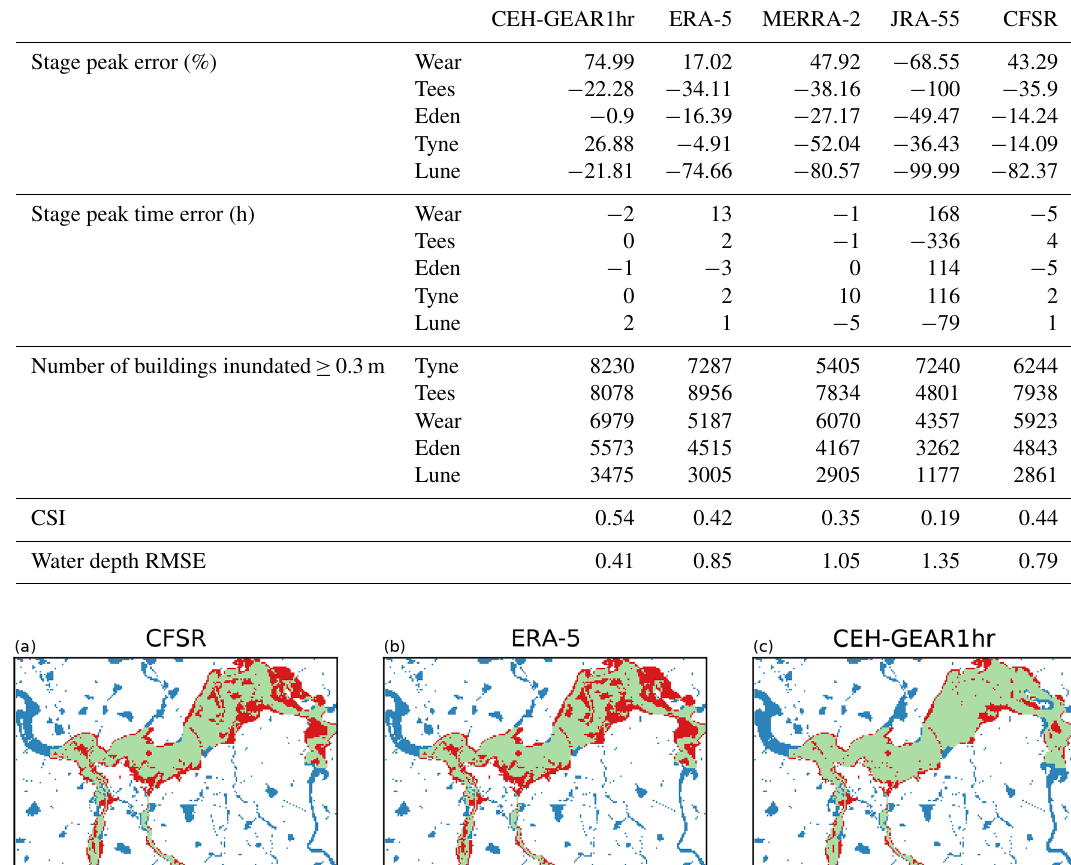
Table 3. Summary of metrics for each model. CSI and water depth RMSE are reported for regions of the Eden basins corresponding to those shown in Figs. 4 and 5.